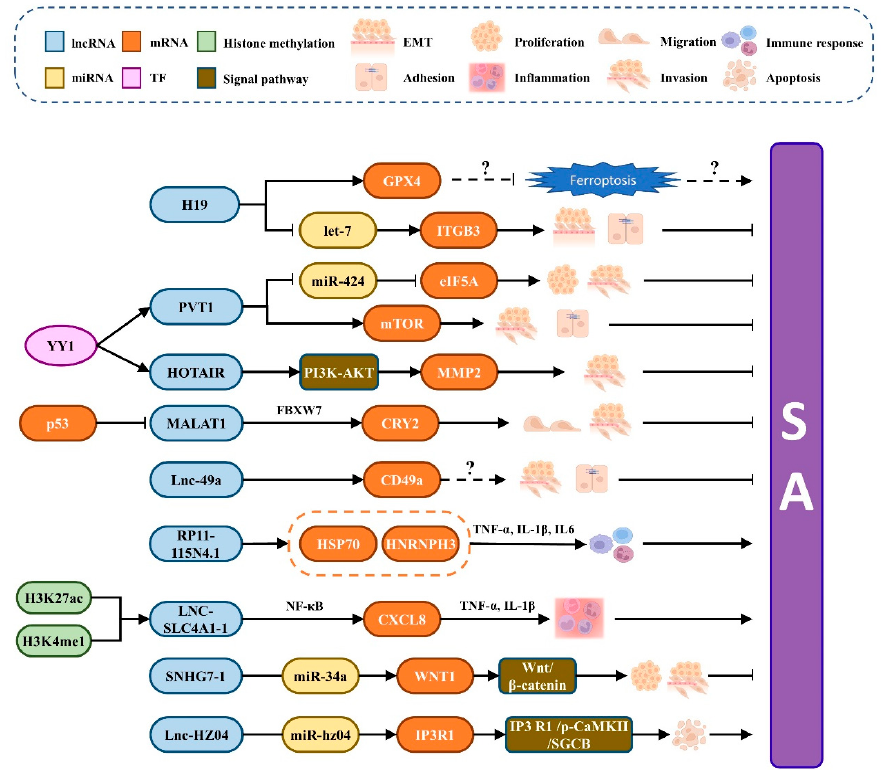
Figure 2. The mechanism for lncRNA to participate in SA. There are two main ways lncRNAs participate in the occurrence and development of SA: (1) directly regulate the expression of target mRNA; (2) regulate the transcription and expression of downstream target mRNA by targeting miRNAs. “?” represents our hypothesis for this regulatory pathway according to existing research.